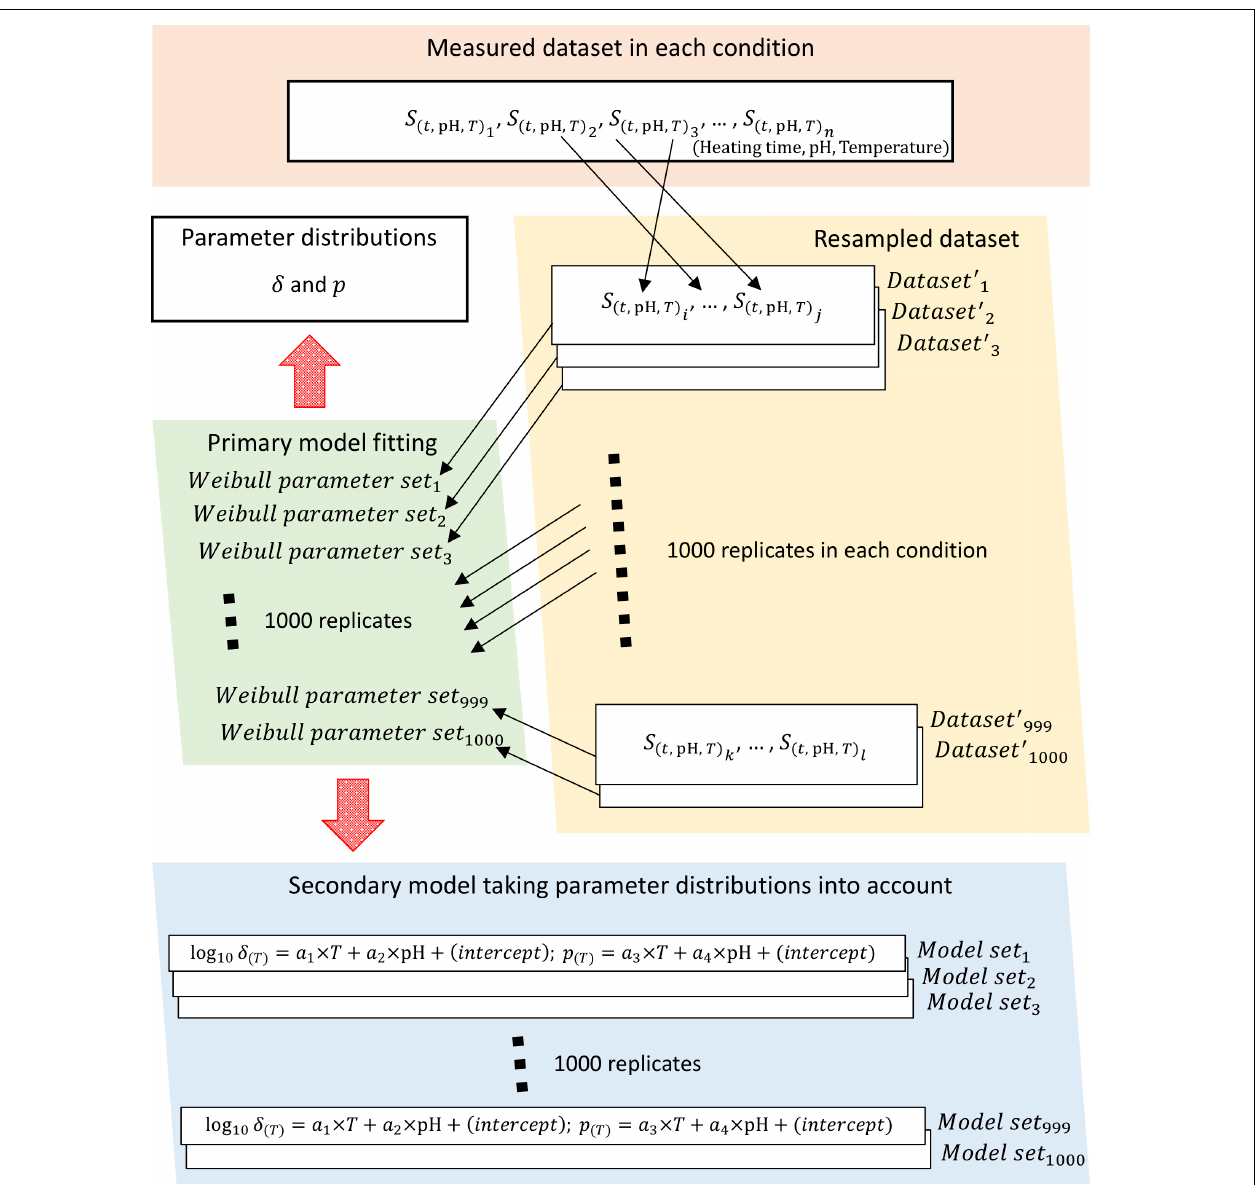
FIGURE 2 | Schematic of the bootstrapping procedure. The bootstrapping was conducted using 1,000 replicates of both the Weibullian parameter distributions and the secondary models for each parameter, with the uncertainty of each parameter considered based on 1,000 replicates of the resampled surviving cell